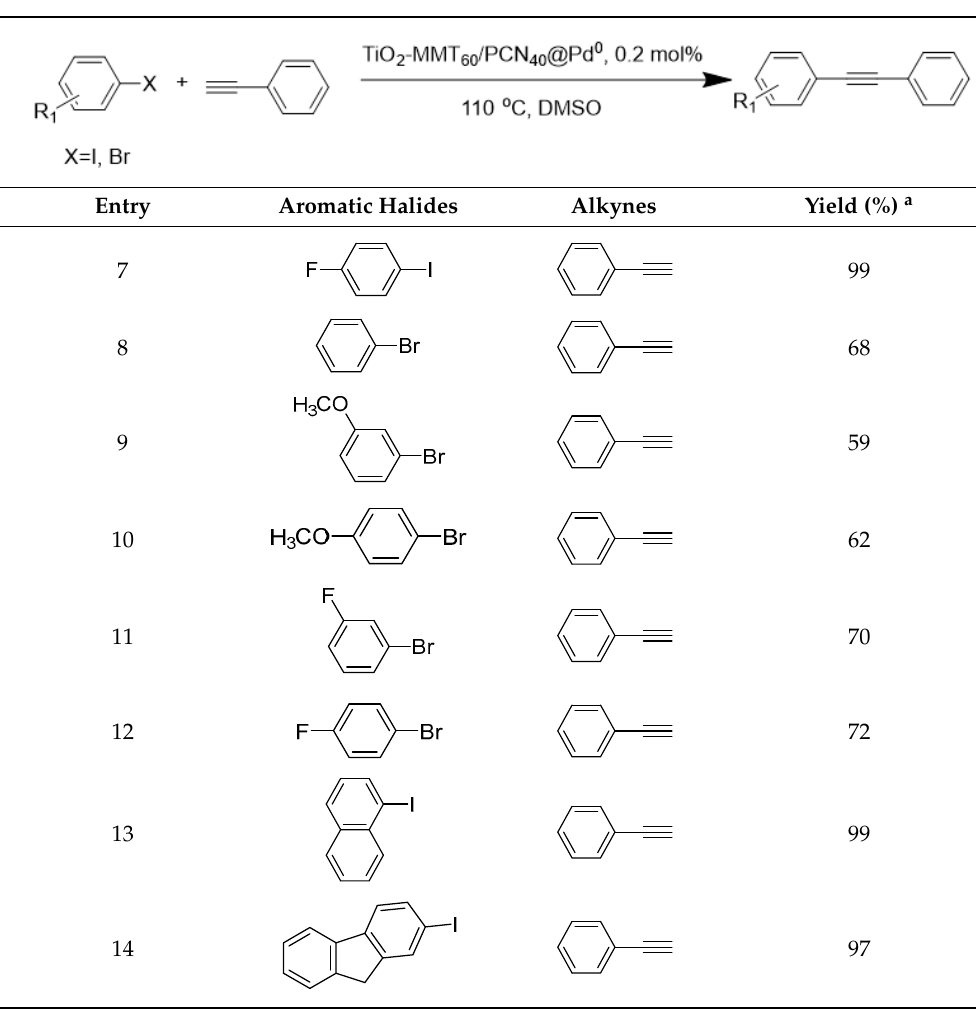
coupling reactions between aromatic halides and alkynes.